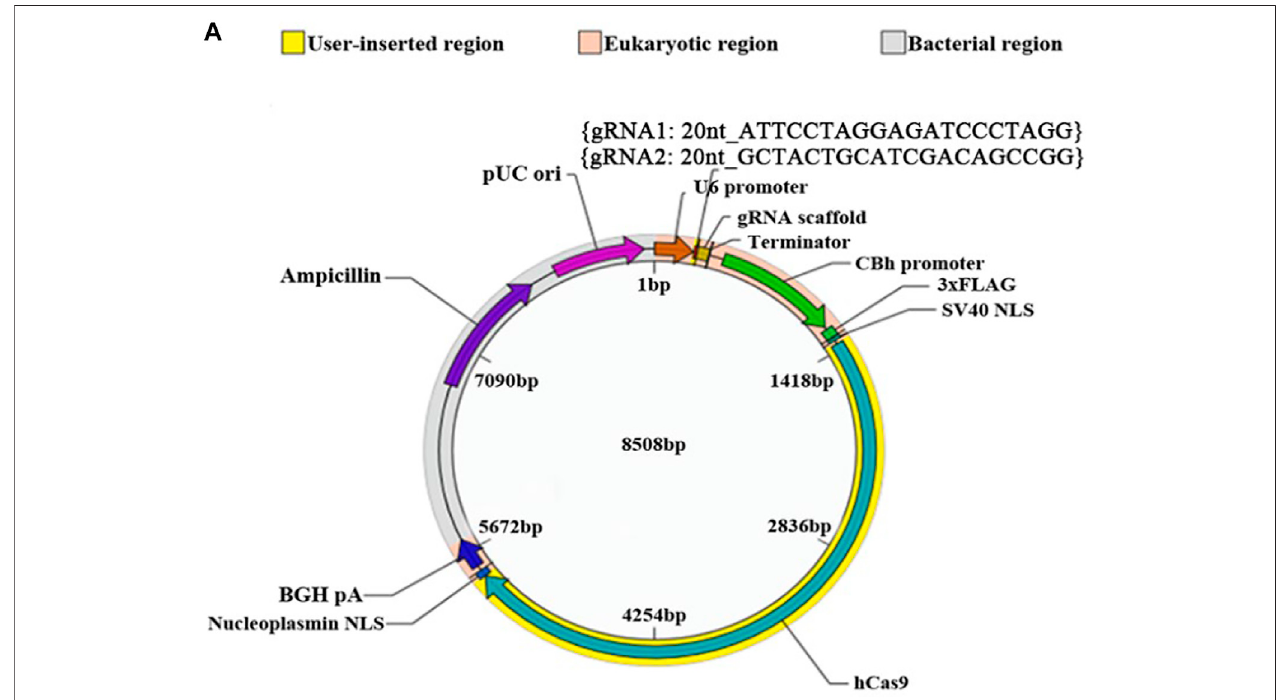
FIGURE6| TheroleofmiR-339anditsregulatoryrelationshipwithPDXKonneuritegrowth atmiR-339knockoutneurons. (A) Theconstructionofvector. (B) Sequencing results: the deleted sequence is black, and the exon sequence is highlighted in blue and red. (C) F1 founder PCR screening: the molecular weight of the wild-type rats is 729 bp; the missing molecular weight of #15, #17, and #21 is 300 bp; the missing molecular weight of #3, #6, and #8 is 202 bp. (D) Electrophoreticband chartforgenotypedetection. Redgreen arrowreferstoheterozygoterats,yellowarrowreferstowild-typerats,and bluearrowrefersto knockout rats. The markers exhibit 100, 250, 500, 750, 1,000, and 2,000 bp, respectively. ± represents heterozygote rats, +/+ represents wild-type rats, and − / − represents the knockout rats. (E) Photomicrographs of neurons detected by Tuj1 staining in Nor, Rea, P-nc, P-si, M-nc and M groups of − / − and +/+ neurons. DAPI counterstaining (blue) demonstrated nuclei of intact cells, and red fl uorescence represented Tuj1 positive staining. Apoptotic neurons were determined by Tuj1 and TUNEL staining, presented by Tuj1 + Tunel +/Tuj1 + (%) in Nor, Rea, P-nc, P-si, M-nc and M groups of − / − and +/+ neurons. DAPI counterstaining (blue) demonstrated nuclei of intact cells, red fl uorescence represented Tuj1, and red fl uorescence represented apoptosis. Scale bar = 50 μ m. (F) The length of axon, cell size, cell numbers and apoptosis rate in Nor, Rea, P-nc, P-si, M-nc and M groups of − / − , +/ − and +/+ neurons. DAPI counterstaining (blue) demonstrated nuclei of intact cells, red fl uorescence represented Tuj1, and red fl uorescence represented apoptosis. Scale bar = 50 μ m. Data were exhibited as mean ± SD. * p < 0.05 vs. +/+, # p < 0.05 vs. P-nc. Nor, normal; Rea, reagent; P-nc, PDXK-nc; P-si, PDXK-si; M-nc, miR-339-mimic-nc; M, miR-339-mimic; WT, wild type; NC, negative control. − / − represents miR-339 knockout homozygote. +/+ represents wild type. ± represents heterozygote. TUNEL, terminal deoxyribonucleotidyl transferase-mediated dUTP-digoxigenin nick-end labeling; DAPI,